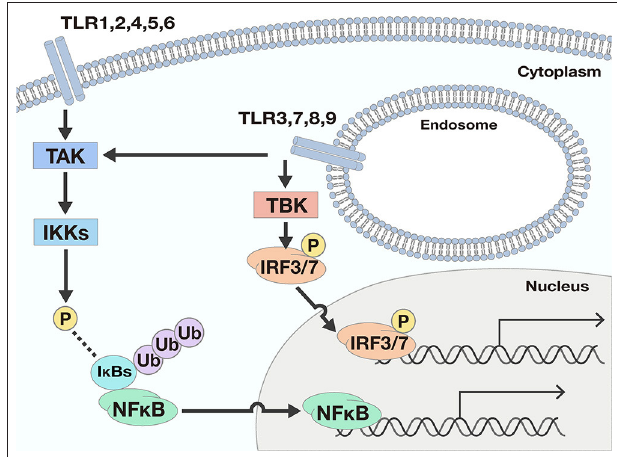
FIGURE 1 | Two downstream signals activated by TLR responses. There are two main downstream signals activated by TLR responses; Nuclear factor- κ B (NF κ B) and interferon (IFN) signals. NF κ B signals are activated by most TLRs. When TLRs recognize ligands, the signal is transferred to activate the I κ B kinases (IKKs) by phosphorylation by TGF- β activating kinase (TAK). The activated IKKs phosphorylate I κ Bs, and the phosphorylated I κ Bs are degraded by a ubiquitin-proteasome system. Consequently, NF κ B is free from I κ Bs and may translocate into the nucleus, resulting in the promotion of many genes’ expression. To the contrary, IFN signals are only promoted by TLR3, 7, 8, and 9. The ligation of TLRs and the corresponding ligand pass through several processes and finally phosphorylate and activate interferon regulatory transcription factor (IRF) 3 or IRF7. Once IRF3 and IRF7 are activated, the transcription factors drive expression from the IFN- β